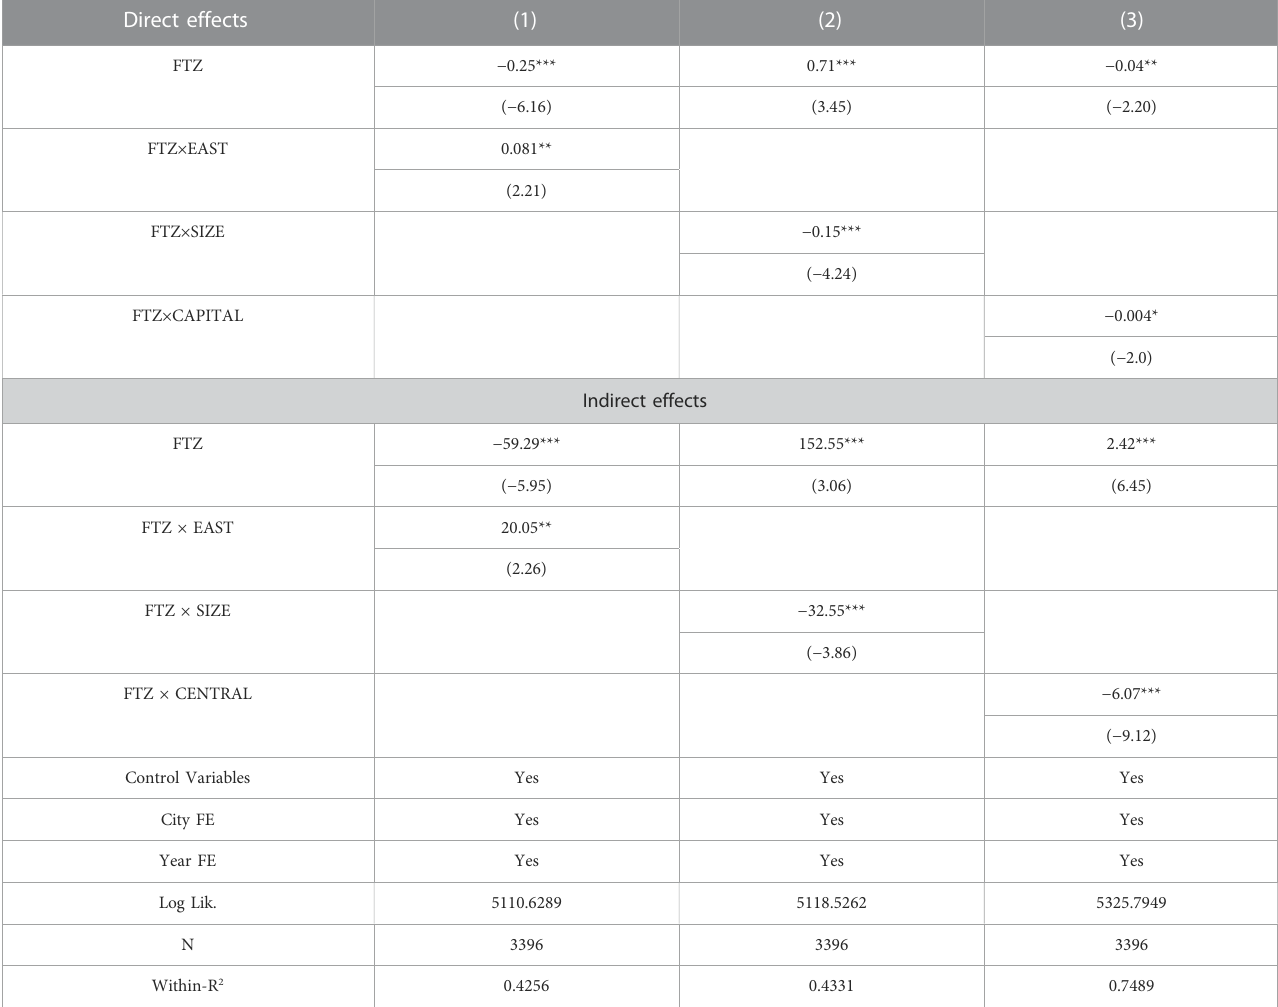
TABLE 11 Direct and indirect effects of the heterogeneity analysis. Direct